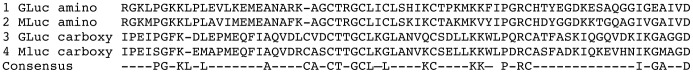
Alignment of both the amino terminal and carboxyl terminal halves of GLuc and MLuc.1) GLuc amino terminal half. 2) Mluc amino terminal half. 3) GLuc carboxyl terminal half. 4) MLuc carboxyl terminal half.